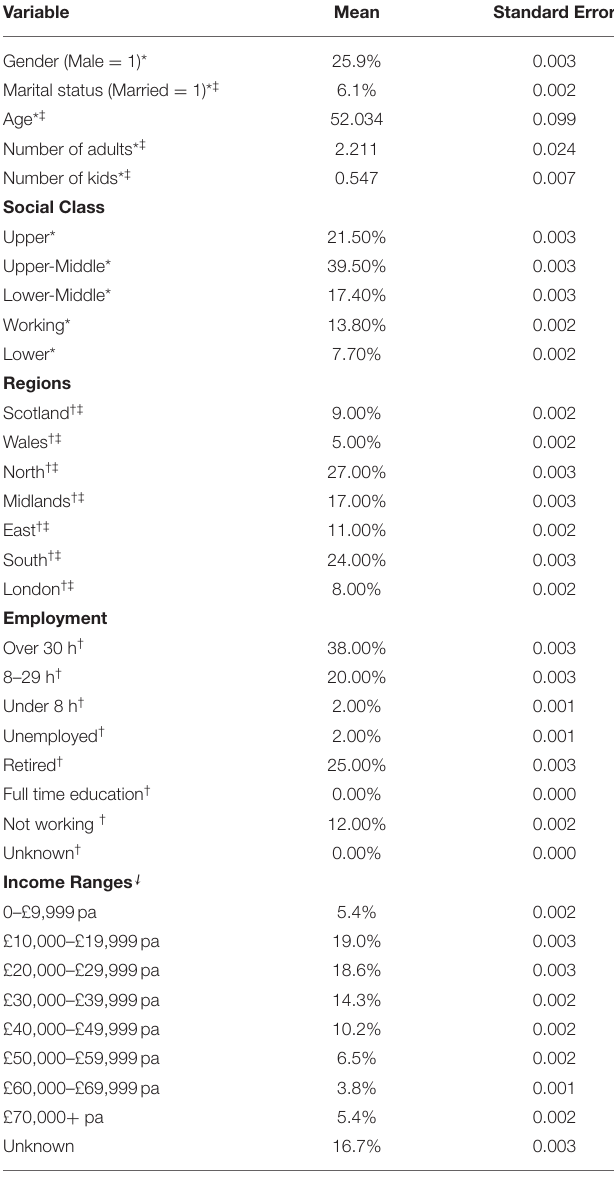
TABLE 2 | Descriptive statistics of household composition and